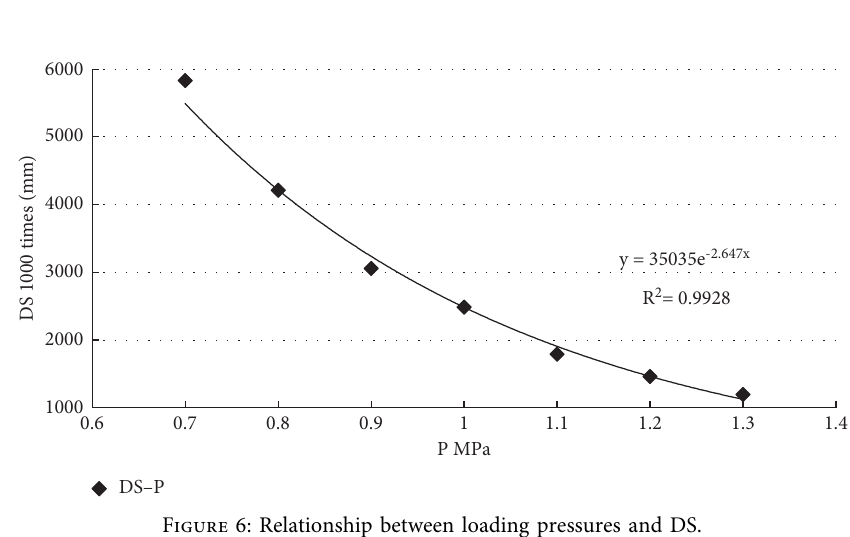
Figure 6: Relationship between loading pressures and DS.